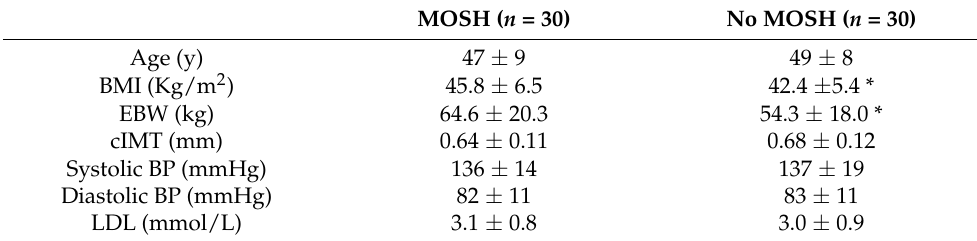
Table 1. Characteristics of men with and without MOSH at